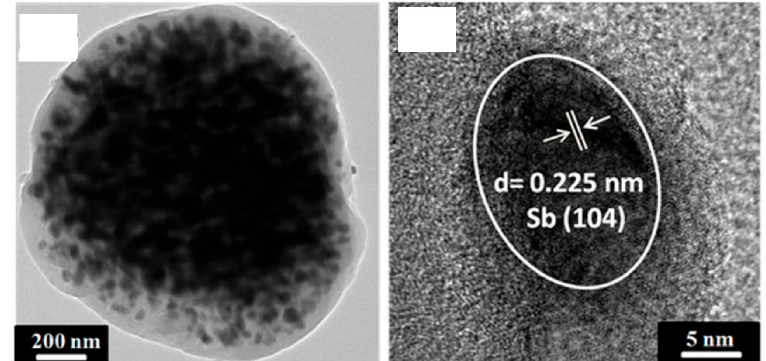
Figure 9. Sb nanoparticles embedded in carbon matrix: ( left ) transmission electron microsopy (TEM) image; ( right ) high resolution TEM (HRTEM) image. (Adapted from [40] with permission from The Royal Society of Chemistry).